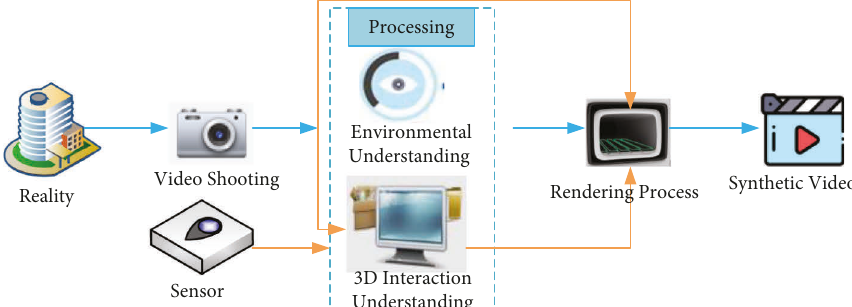
Figure 6: The application of virtual reality technology in digital video special effects.